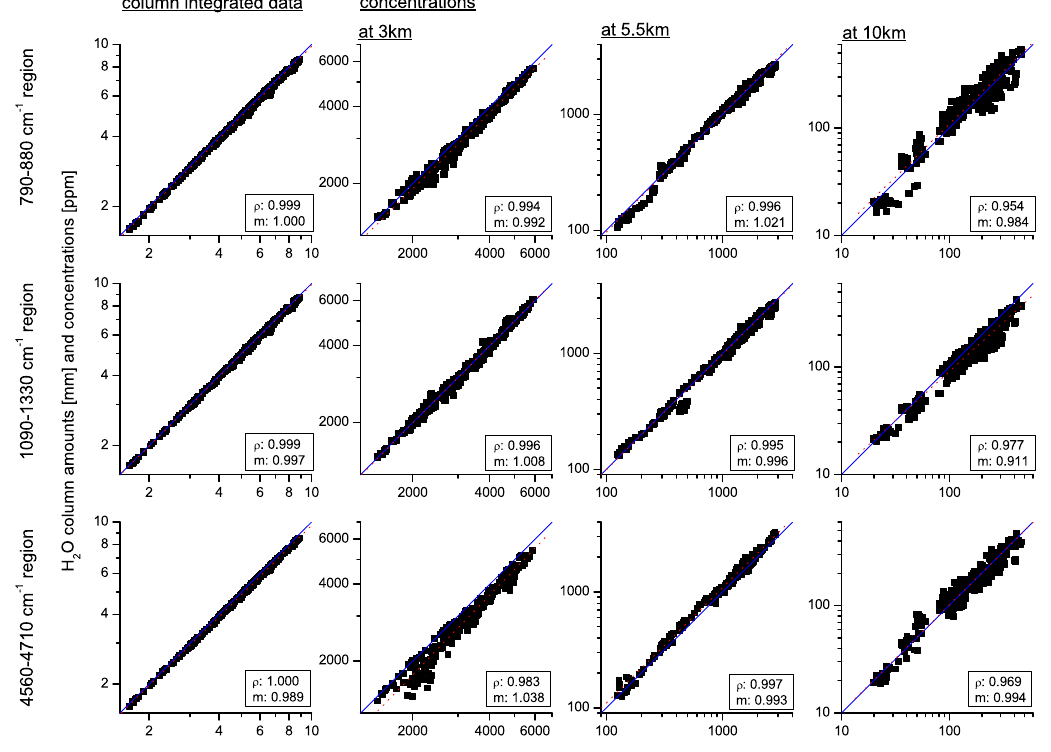
Fig. 13. Correlation between the 325 H 2 O profile retrieved for the different spectral regions. Top panels: 790–880cm − 1 region ( y -axes) versus 2650–3180cm − 1 region ( x -axis); Central panel: 1090–1330cm − 1 region ( y -axes) versus 2650–3180cm − 1 region ( x -axis); Bottom panels: 4560–4710cm − 1 region ( y -axes) versus 2650–3180cm − 1 region ( x -axis). From left to right: total column amounts (in mm), volume mixing ratios (in ppm) for the lower, middle, and upper troposphere (3, 5 . 5, 10km, respectively). The blue solid line indicates the diagonal and the red dotted line the linear regression line. The correlation coefficient ρ and the slope of the linear regression line m are written in each panel.